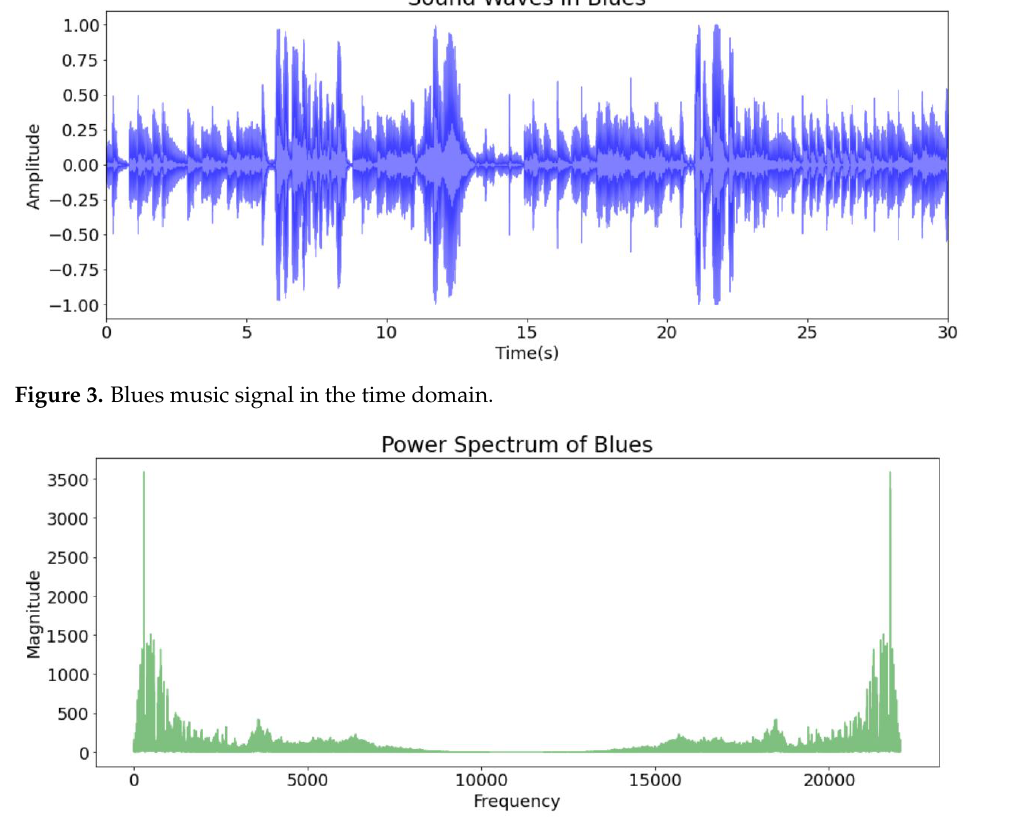
Figure 4. Blues music signal in the frequency